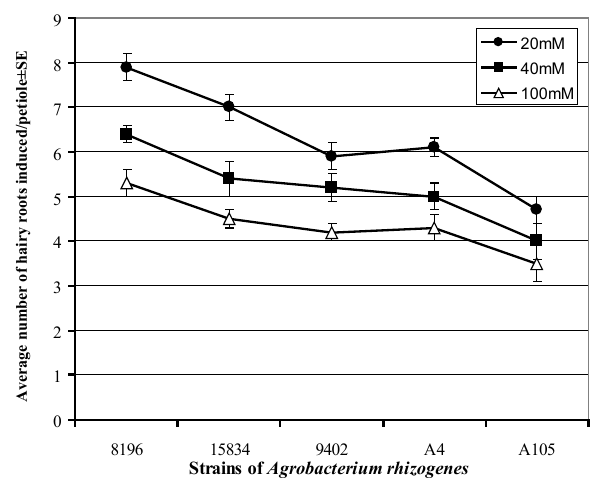
Fig. 11. Effect of acetosyringone on number of hairy roots in- duced in petiole of